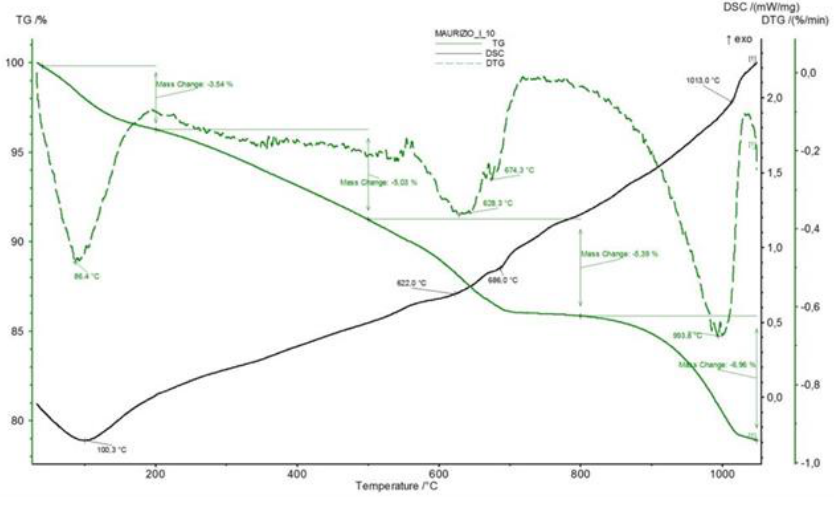
Figure 9. DTA and TG analysis of the plaster.